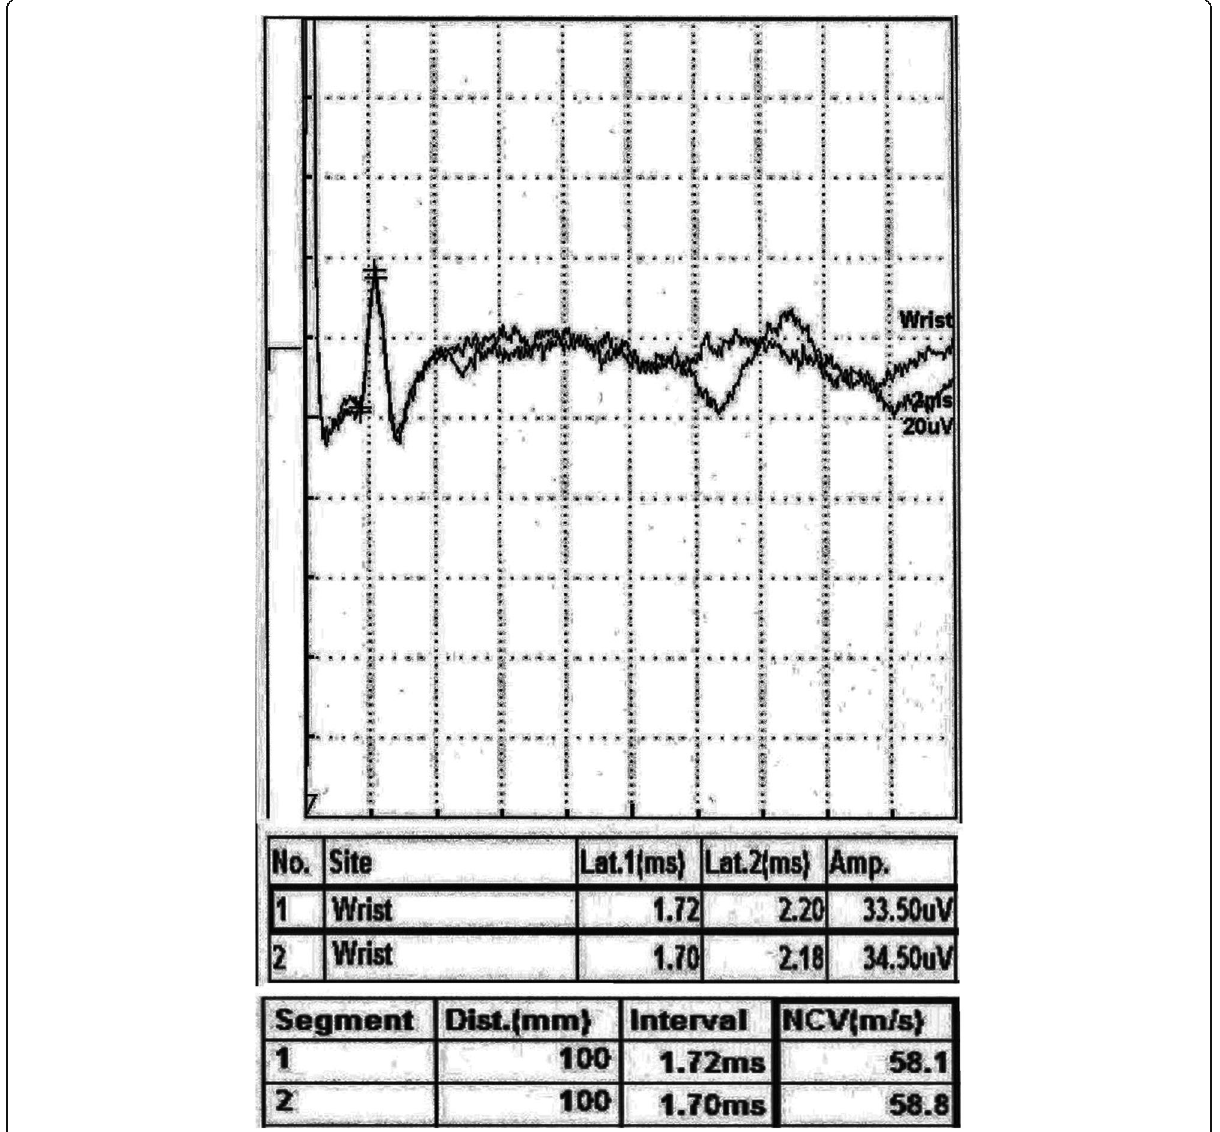
Fig. 5 Sample tracings show the superficial radial nerve sensory nerve action potentials of an apparently healthy